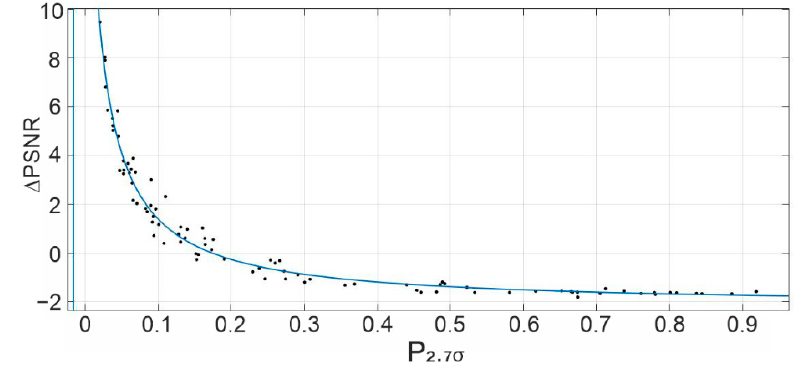
Figure 10. The scatter-plot ∆𝑃𝑆𝑁𝑅 vs. 𝑃 2.7𝜎 and the fitted curve.